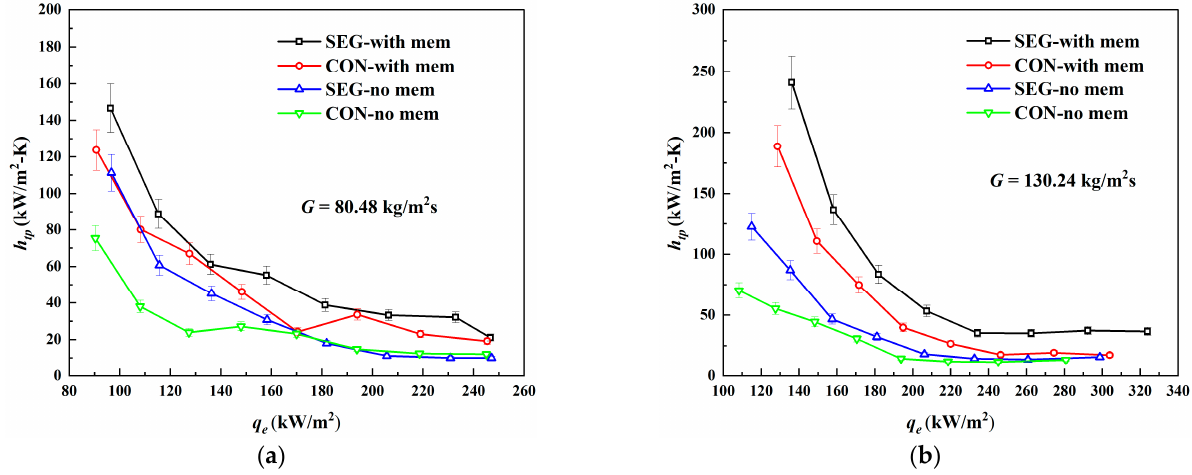
Figure 14. Two-phase heat transfer coefficients in the continuous and segmented heat sinks with and without the venting membrane: ( a ) G = 80.48 kg m − 2 s − 1 ; ( b ) G = 130.24 kg m − 2 s − 1 .